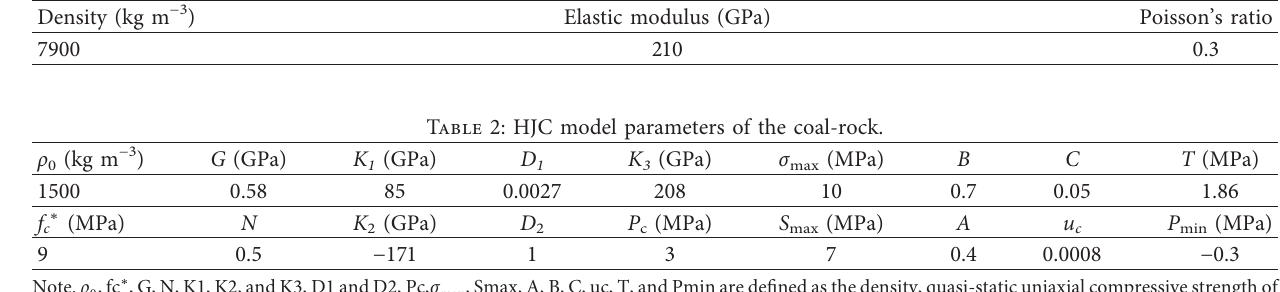
Table 1: Rigid body model parameters.